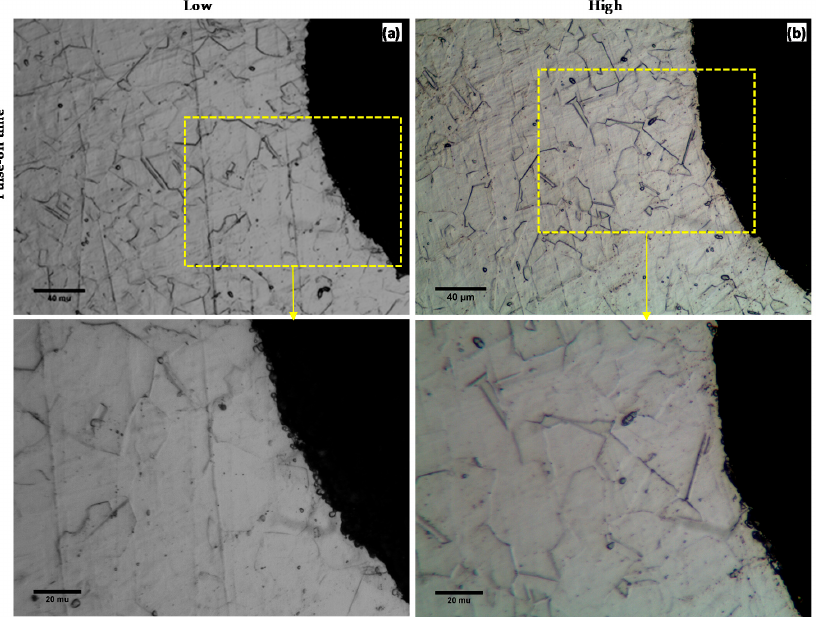
Figure 13. Microstructure of WEDM machined surfaces at ( a ) low TON (1 MU) ( b ) high TON (9 MU).